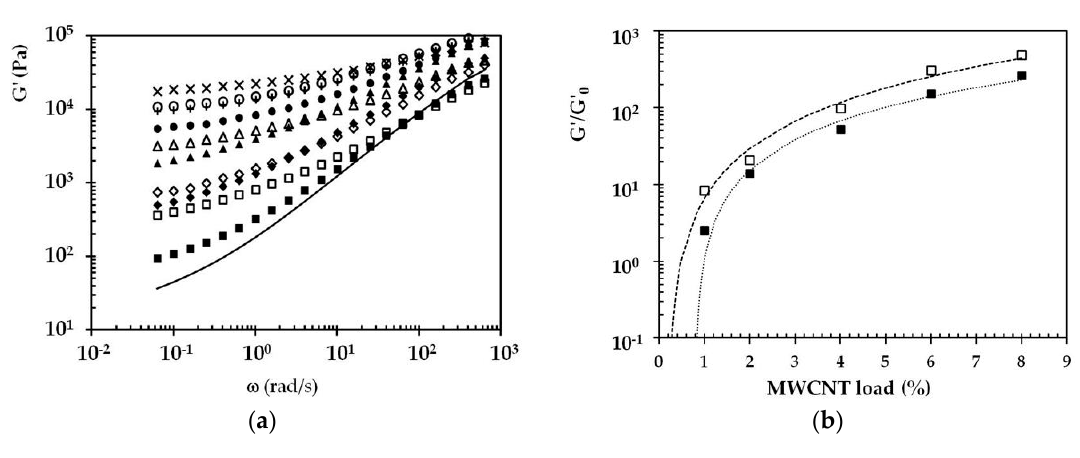
Figure 1. ( a ) Storage modulus as a function of frequency for both nanocomposites. Line corresponds to unloaded irradiated PP 80Kgy. Protocol A (filled symbols), PP/MWCNT 80 kGy: ( ) 1%, ( ) 2%, ( ) 4%, ( ) 6%, ( ) 8%, Protocol B (empty symbols), PP 80 kGy/MWCNT: ( ) 1%, ( ◊ ) 2%, ( ) 4%, ( ) 6%, ( ) 8%; ( b ) percolation plot: G’/G’ 0 versus MWCNT load for both nanocomposites. The